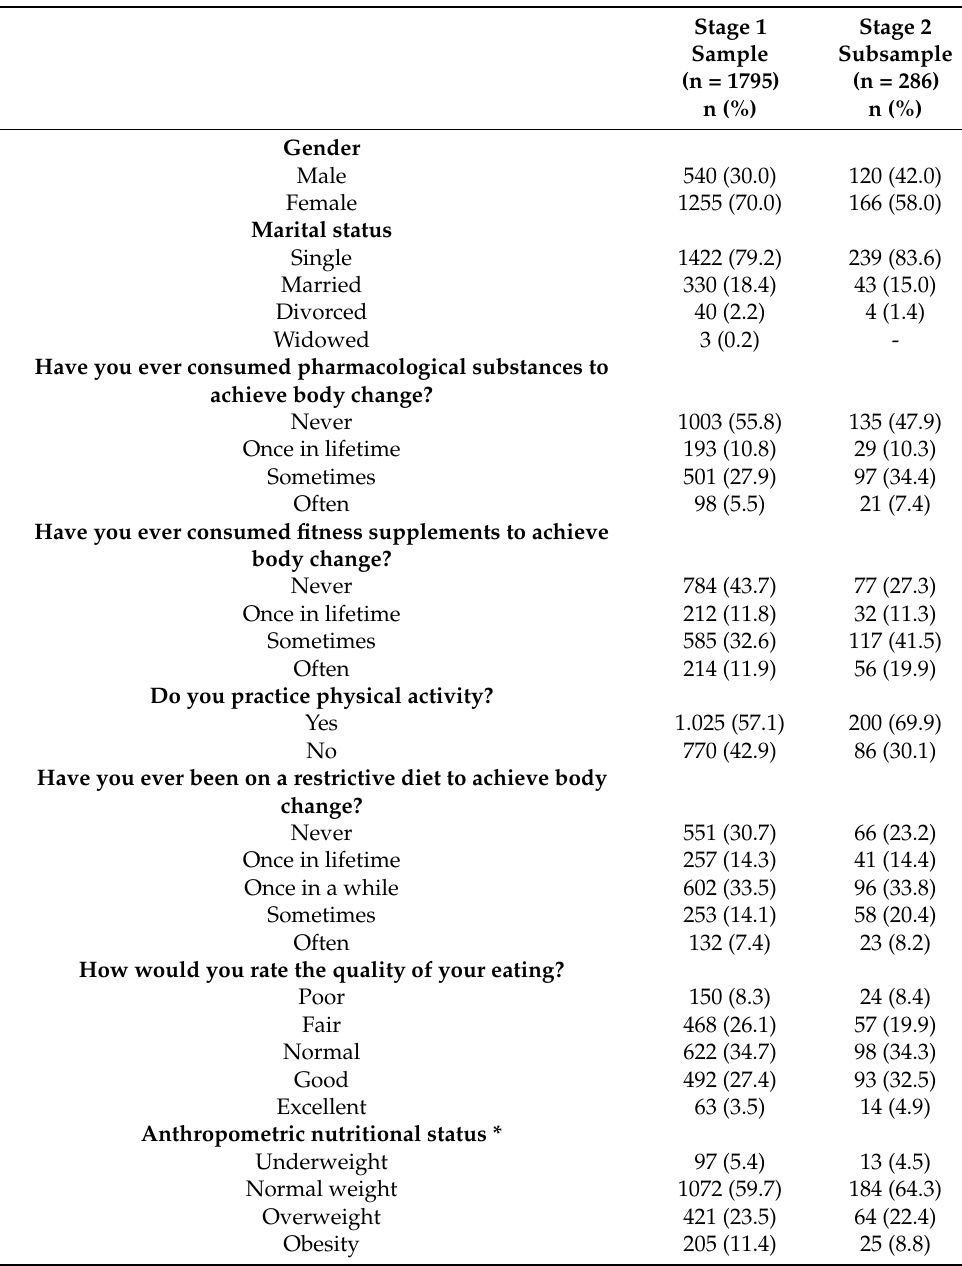
Table 1. Characterization of study participants considering the two stages of the